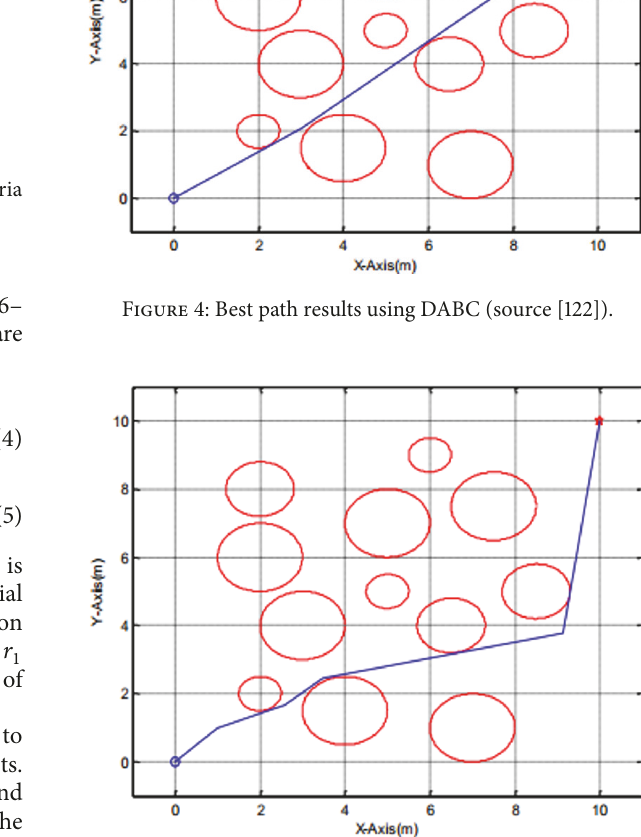
Figure 5: Best path results using ABC (source